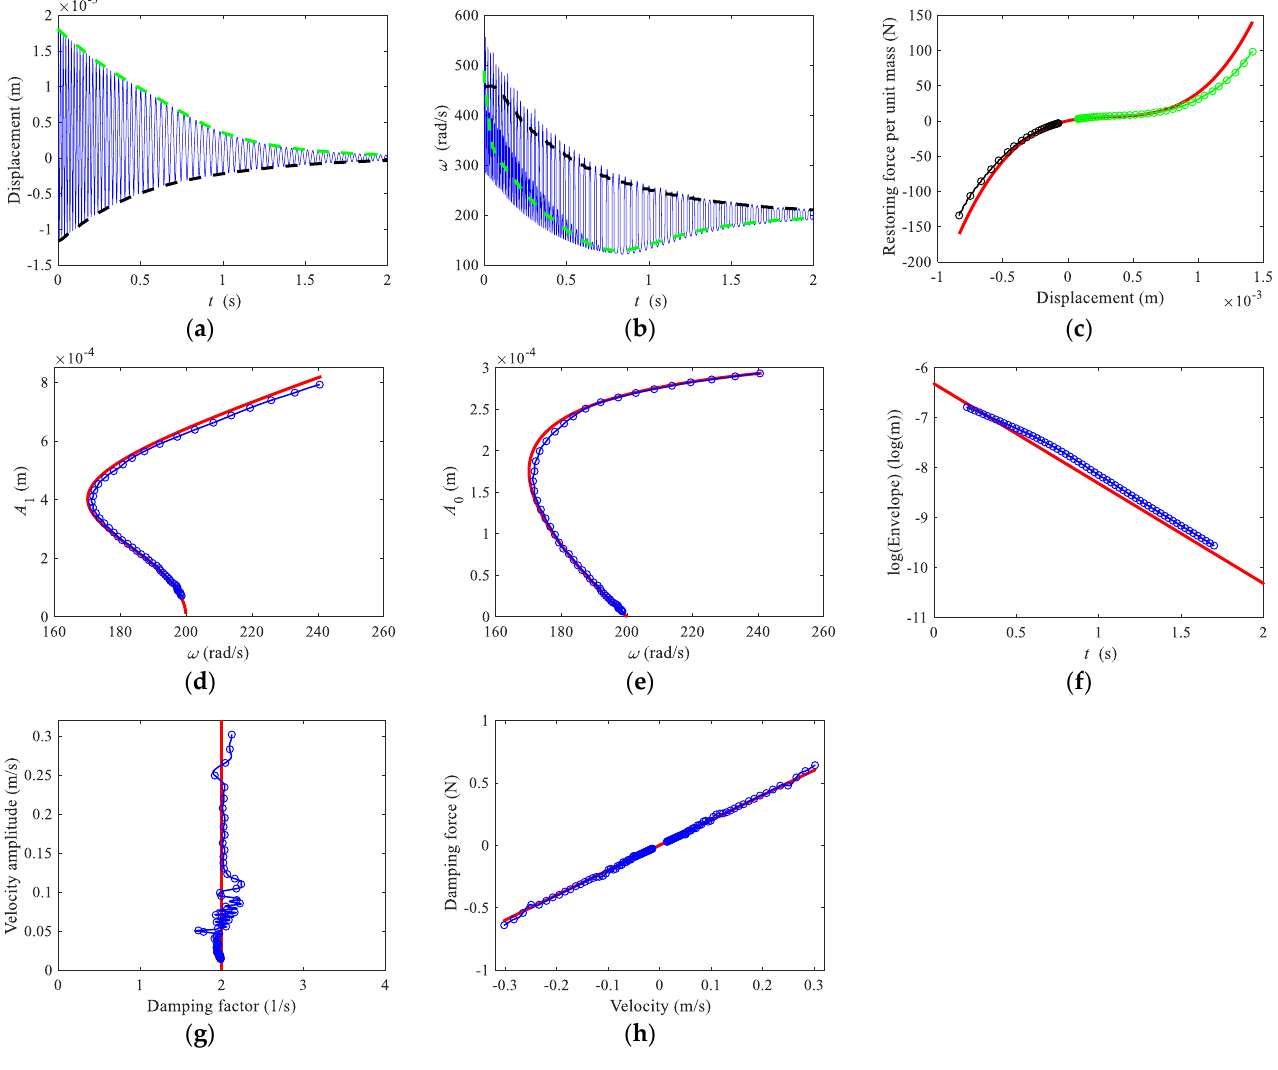
Figure 4. Direct quadrature. ( a ) Time domain response and envelopes, ( b ) frequencies, ( c ) restoring force curve, ( d ) backbone curve of first harmonic term A 1 , ( e ) backbone curve of bias term A 0 , ( f ) logarithmic form of the envelope, ( g ) damping factor, ( h ) damping force curve. Thin solid lines, time domain response in ( a ) and instantaneous frequency in ( b ); dashed lines, positive and negative envelopes in ( a ) and frequencies in ( b ). In ( c – h ), thick solid lines, analytical solutions; lines with circles, numerical results.